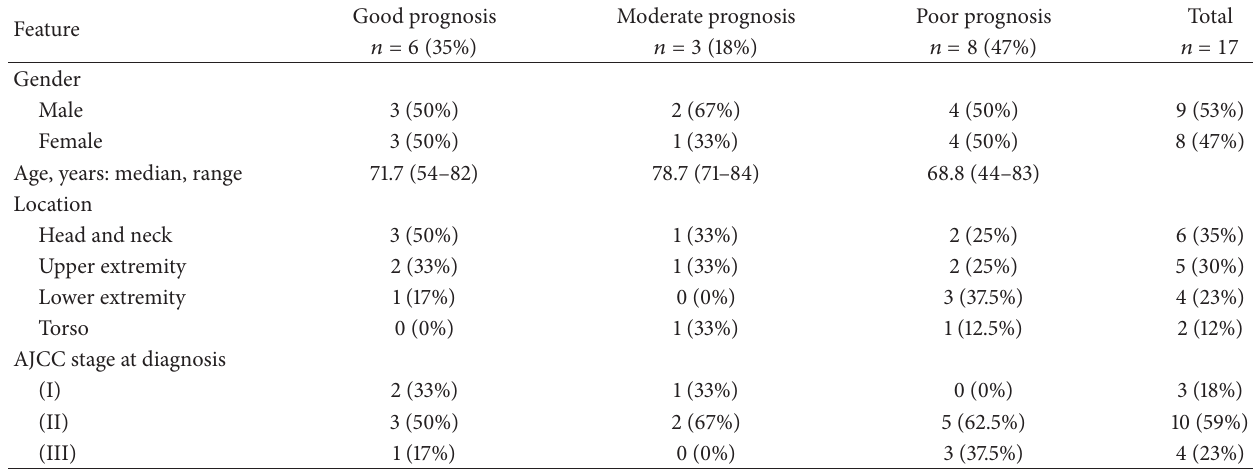
Table 1: Clinical characteristics of the 17 MCC patients utilized in